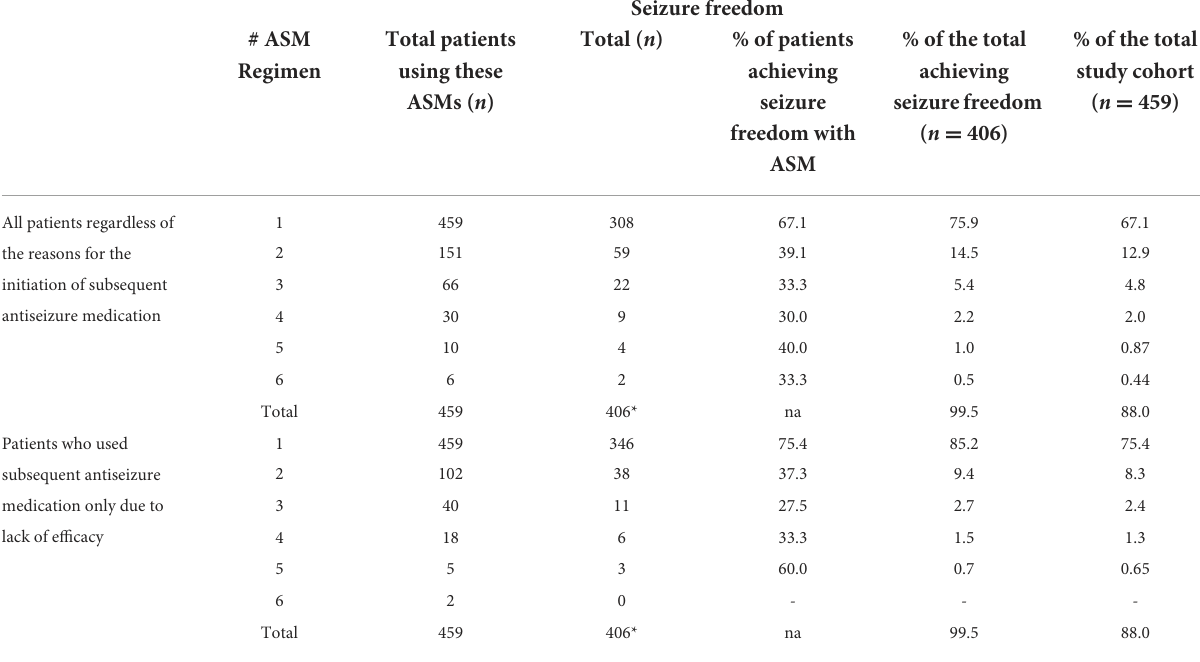
TABLE 1 Antiseizure medication schedules.